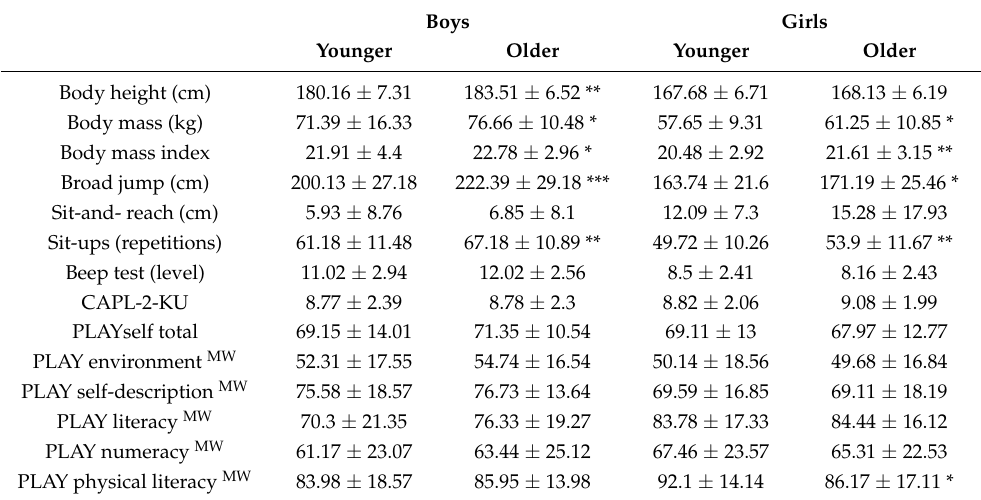
Table 2. Descriptive statistics and differences between age groups (data are given as means ± SD).